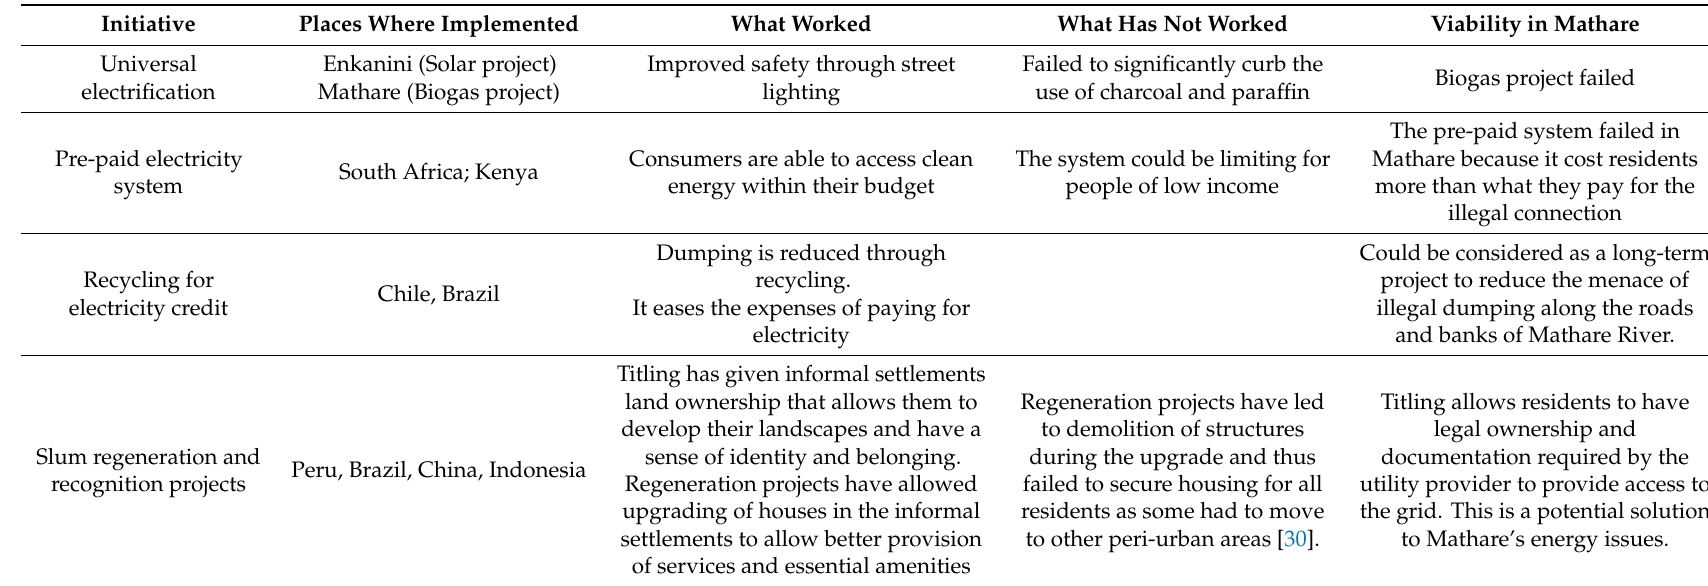
Table 1. Summary of initiatives that can be implemented in Mathare: Lessons from other areas (Source: